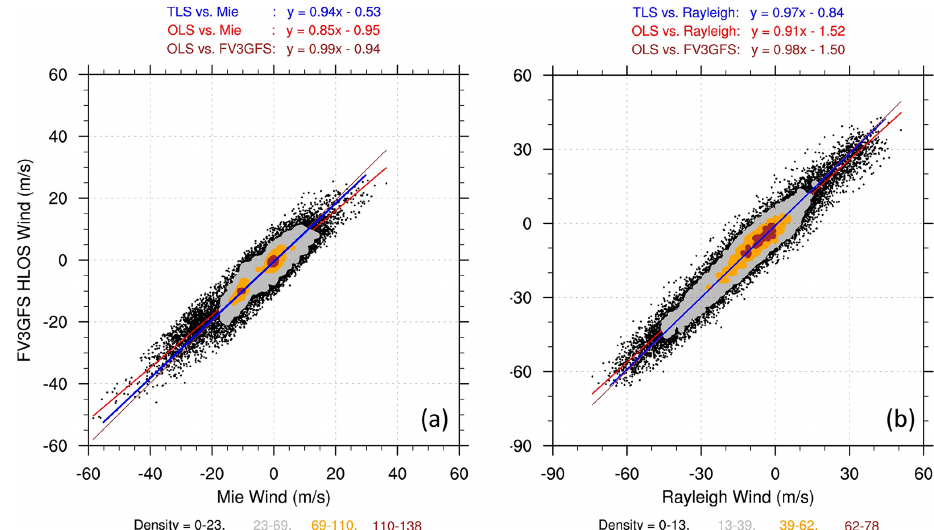
Figure 4. Density plots of global collocated (a) Mie and FV3GFS winds in the layer at ∼ 3 . 5km altitude and (b) Rayleigh and FV3GFS winds in the layer at ∼ 15km altitude in descending orbits. The TLS analysis lines (blue), the OLS regression lines of FV3GFS winds on Aeolus winds (red), and the OLS regression lines of Aeolus winds on FV3GFS winds (transformed and plotted as a function of Aeolus winds in brown) are shown, with the corresponding regression coefficients displayed above each panel.